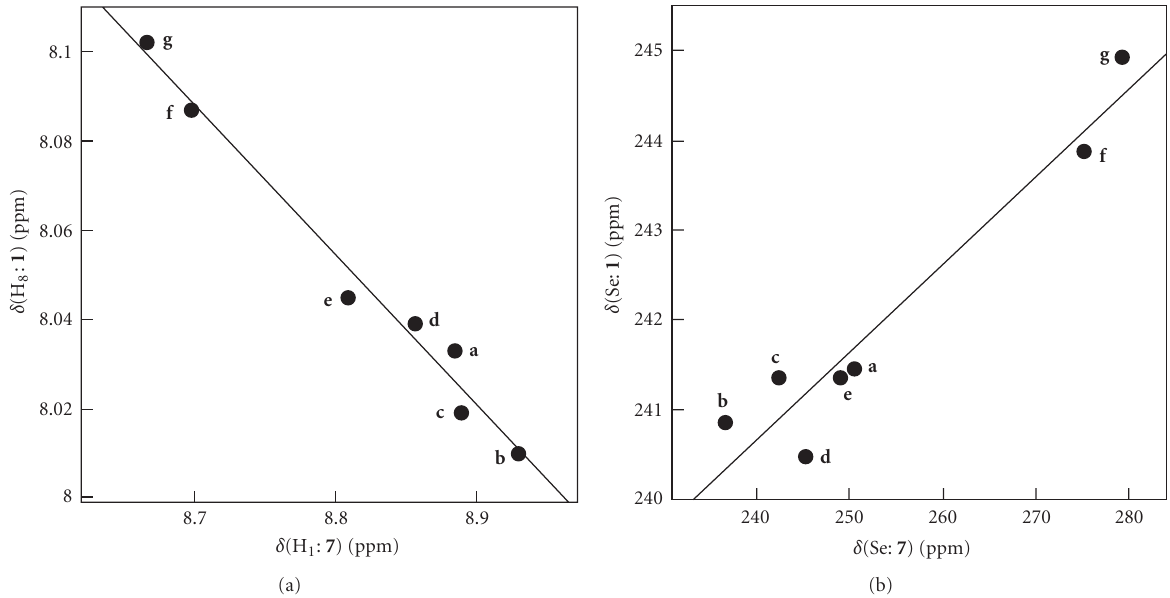
Figure 5: Plots of δ (H 8 : 1 ) versus δ (H 1 : 7 ) (a) and δ (Se: 1 ) versus δ (Se: 7 )